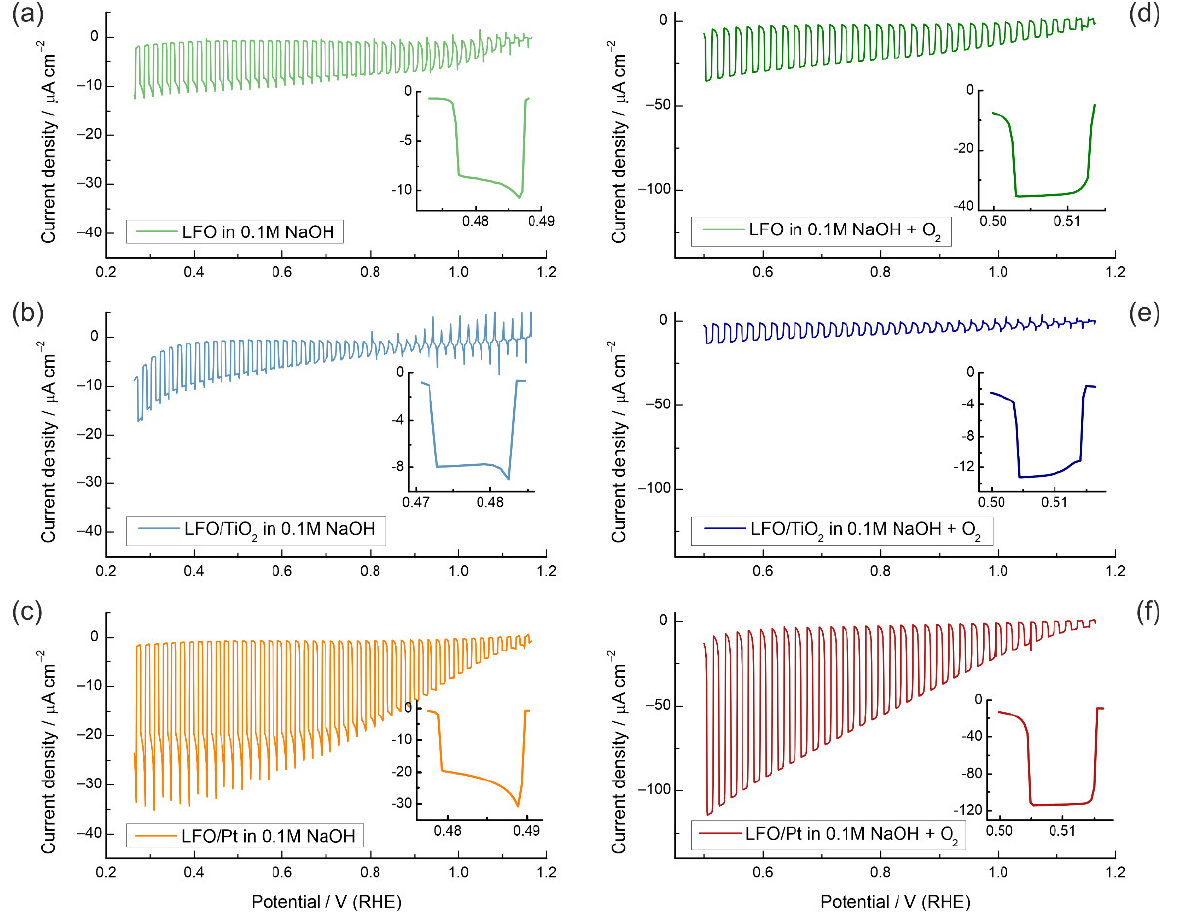
Figure 3. Linear sweep voltammograms at 5 mV s −1 under a square-wave 460 nm light perturbation for pristine LFO, LFO/TiO 2 (1:100) and LFO/Pt samples in deaerated 0.1 M NaOH ( a – c ) and O 2 -saturated 0.1 M NaOH ( d – f ). The inserts show the enlarged portions of the voltammograms in the 0.48–0.51 V range to illustrate the difference in current decays.